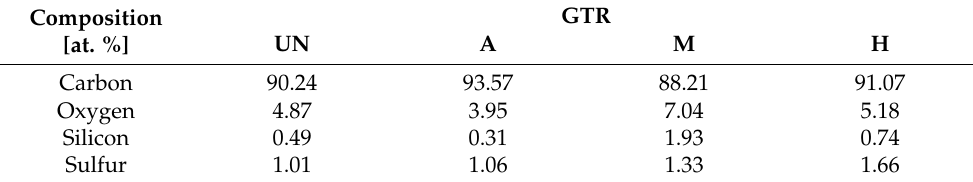
Figure 7. FT-IR spectra for GTRs’ particles. Table 4. Composition of GTRs studied by EDS (limited to the most important